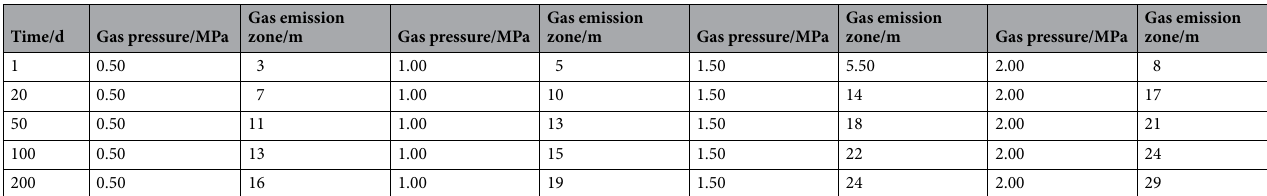
Table 4. The results of simulation under different gas pressures.